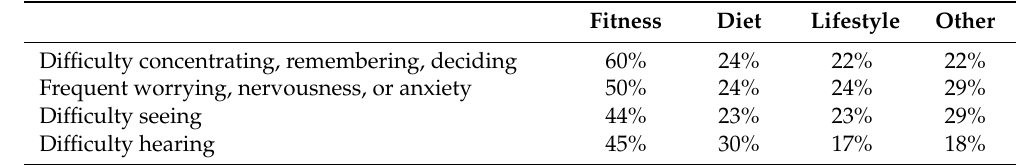
Table 3. “Which of the following types of health and wellness apps do you use? (Check all that apply)”, by disability